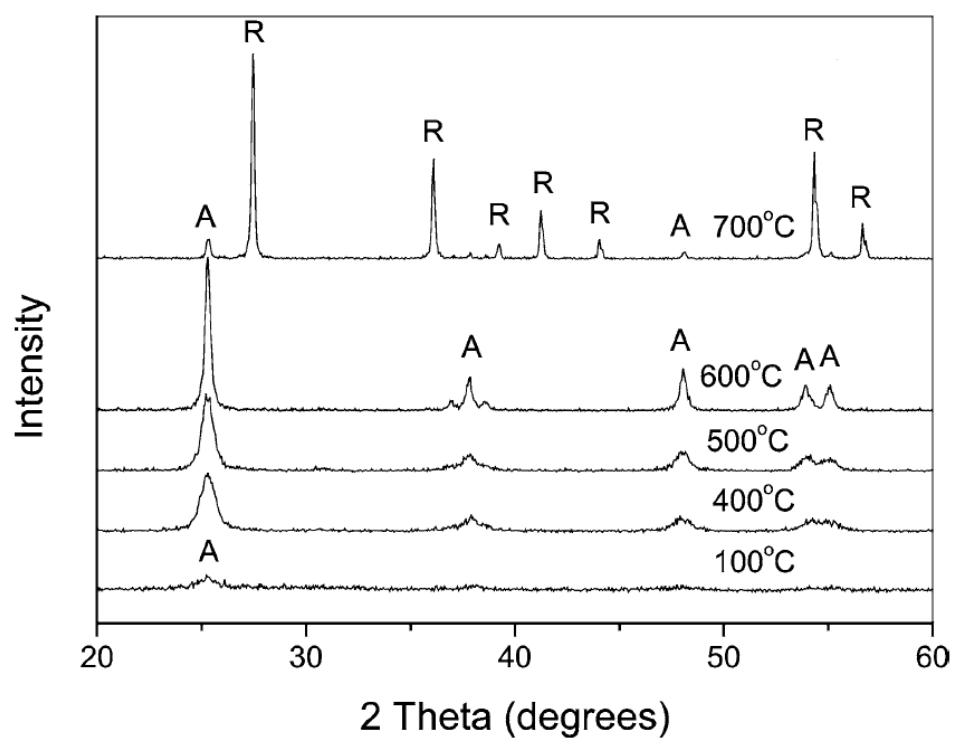
Figure 9. Evolution of the XRD pattern of a TiO 2 sample peptized with NH 4 OH and calcined at different temperatures, from [91]. The A and R labels stand for anatase and rutile phases, respectively (reproduced with permission from J. Yu et al., Journal of Catalysis; published by Elsevier, 2003).